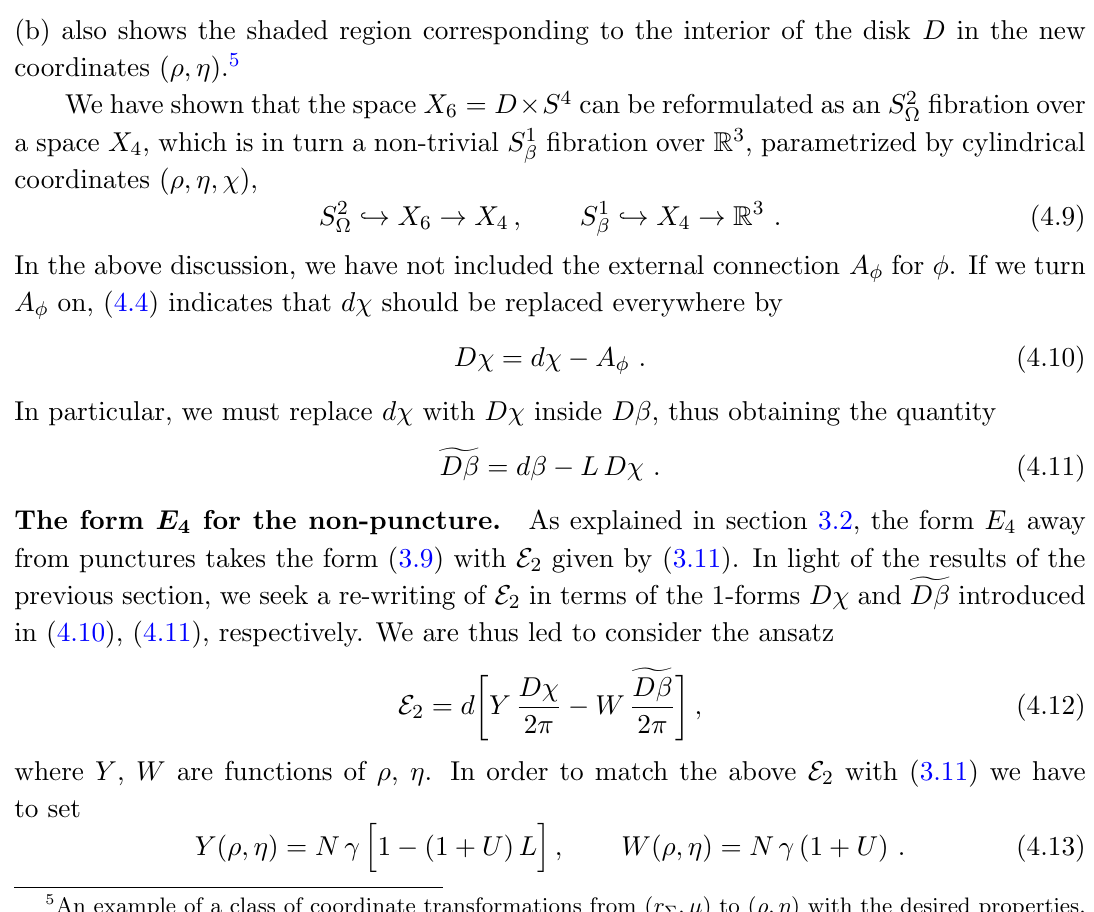
Figure 1 . The plot on the left depicts the ( r (cid:6) ; (cid:22) ) strip, with r (cid:6) on the horizontal axis, and (cid:22) on the vertical axis. Lines of constant (cid:22) (solid, grey) and lines of constant r (cid:6) (dashed, grey) are also included. The plot on the right depicts the ( (cid:26); (cid:17) ) quadrant, with (cid:26) on the horizontal axis, and (cid:17) on the vertical axis. We include the image of lines of constant (cid:22) and r (cid:6) . The shaded regions in both plots correspond to the subregion r (cid:6) < r 0 , with r 0